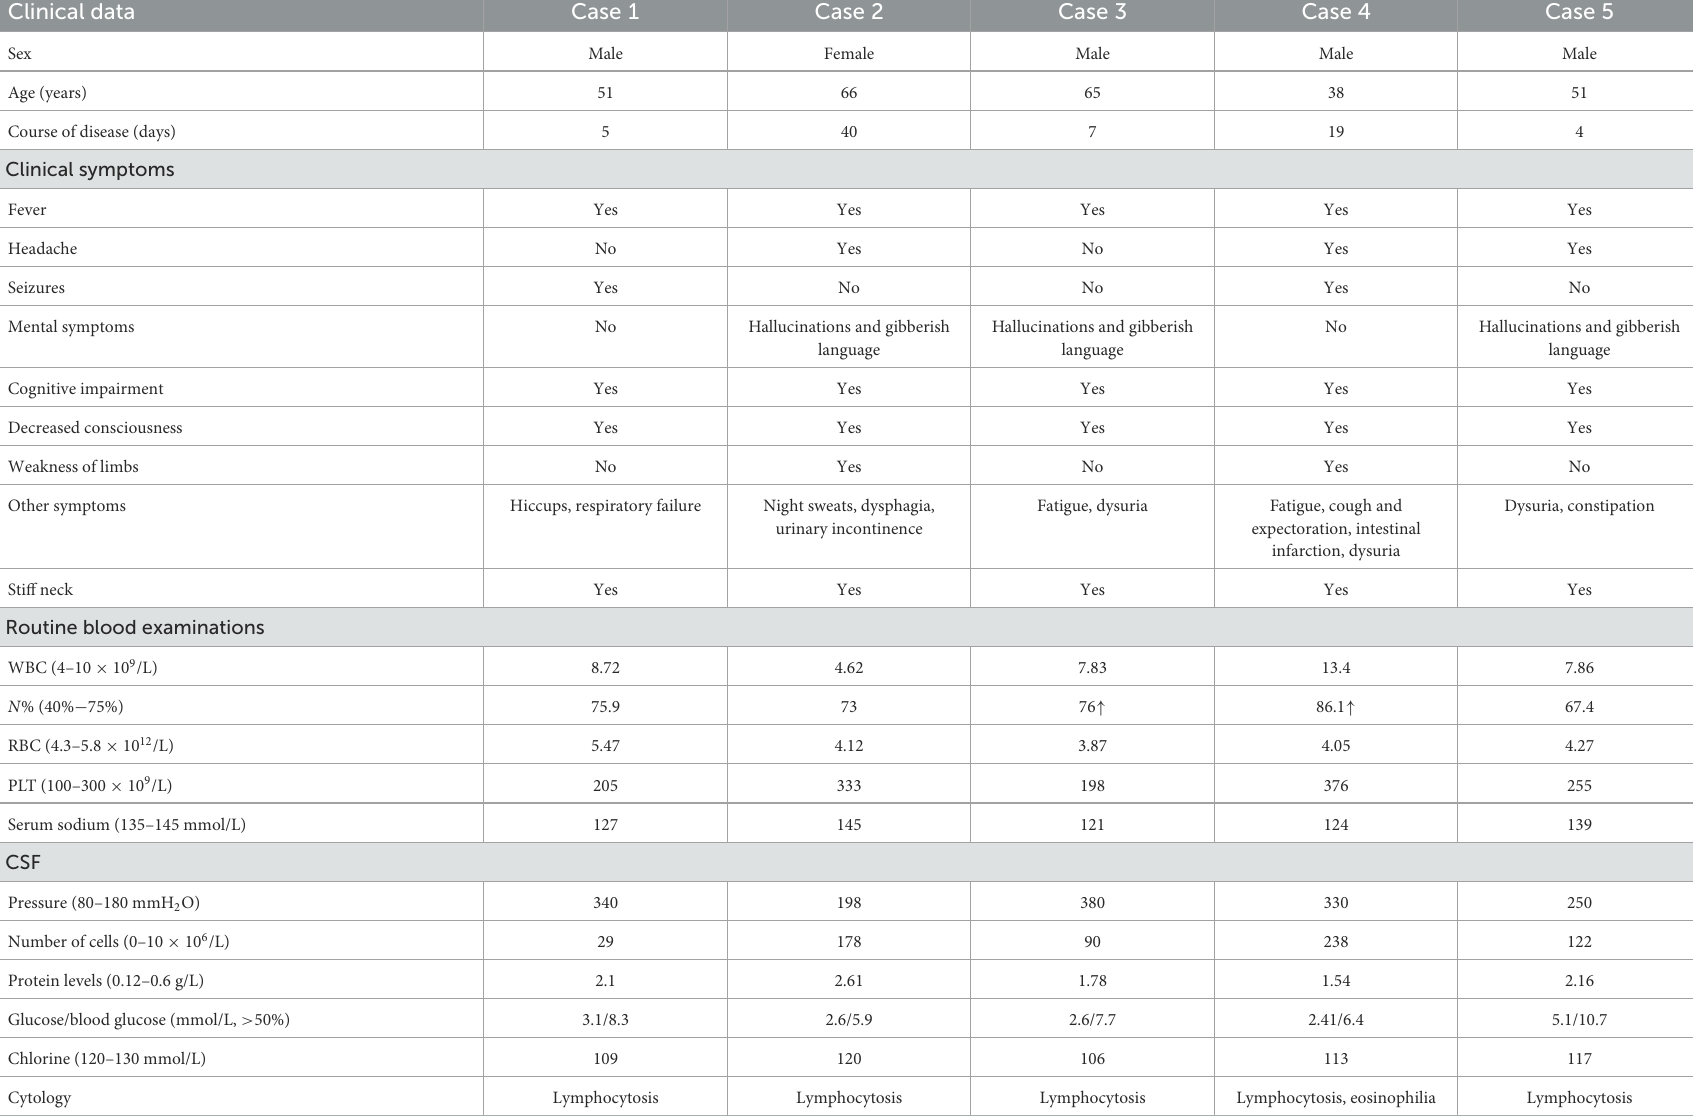
TABLE 1 Clinical data of five patients. Clinical